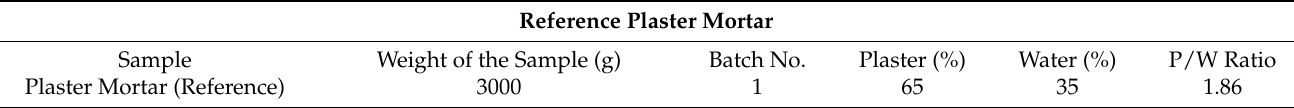
Table 3. Reference data on gypsum mortar samples.